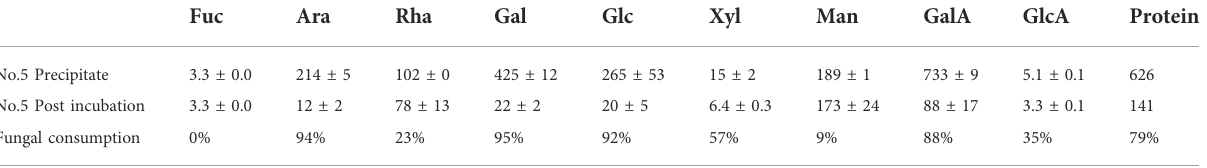
TABLE 4 Monosaccharide composition analysis of the polysaccharide extract (fraction No. 5) before and after four days of inoculation with P. sclerotigenum . The values are the average of three independent measurements